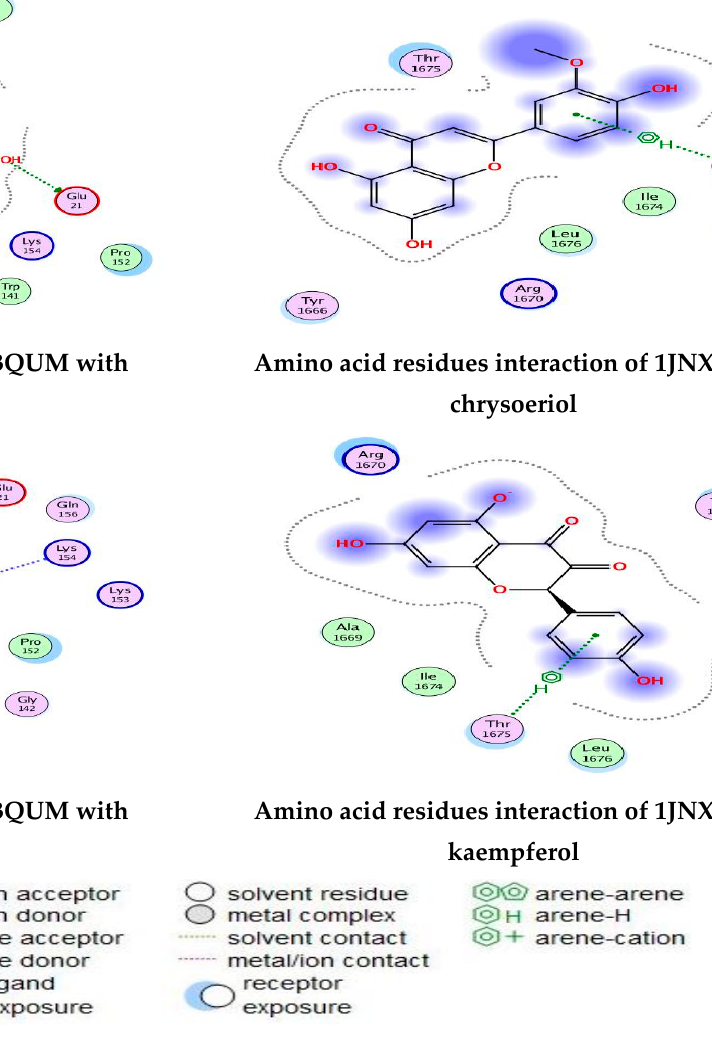
Figure 12. Amino acid residue interactions of different proteins with active compounds, and the representative key of the types of interaction between active compounds and proteins. Table 7. Docking scores and energies of compounds with 7BCZ, 7C7N, 3QUM, and 1JNX proteins.